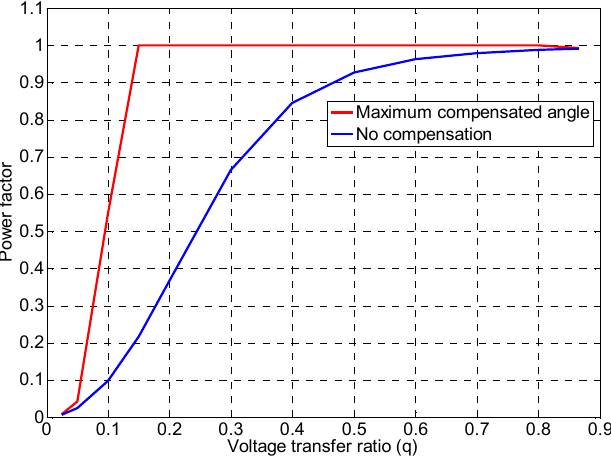
Figure 17. Comparison between IPF under no compensation and maximum compensated angle conditions at Q = 0.1. At 0.375 Q =